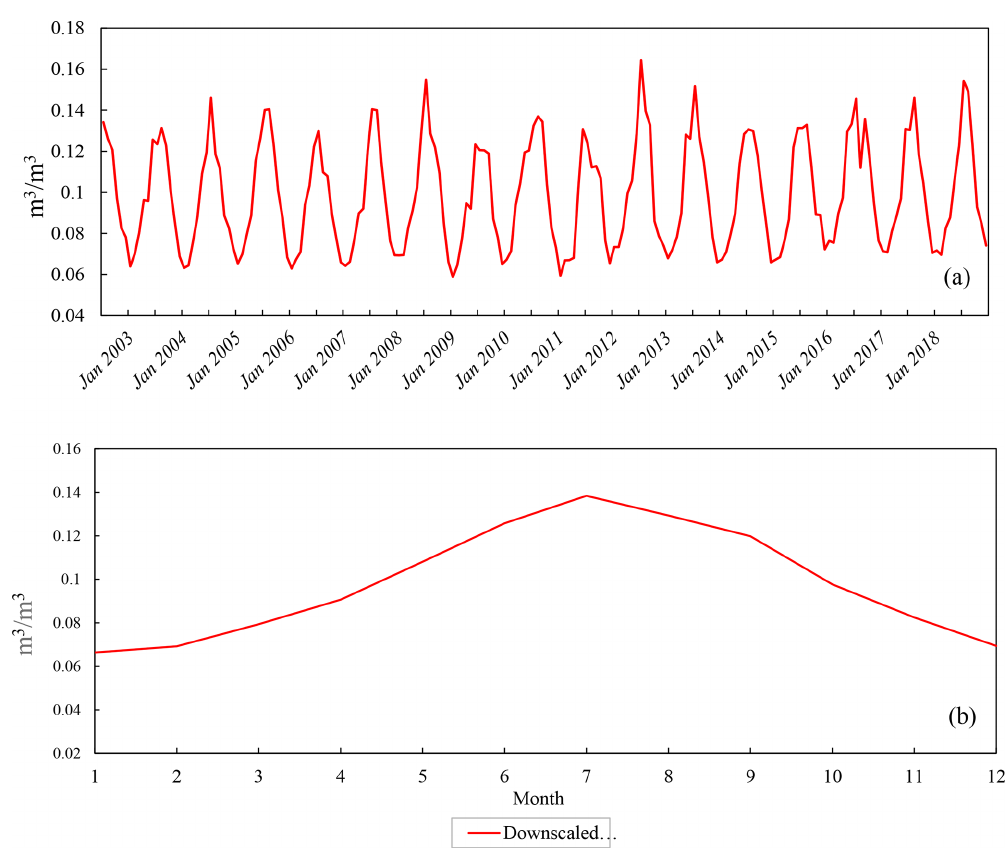
Figure 6. Time series of the area mean downscaled SM during the study period from June 2002 to December